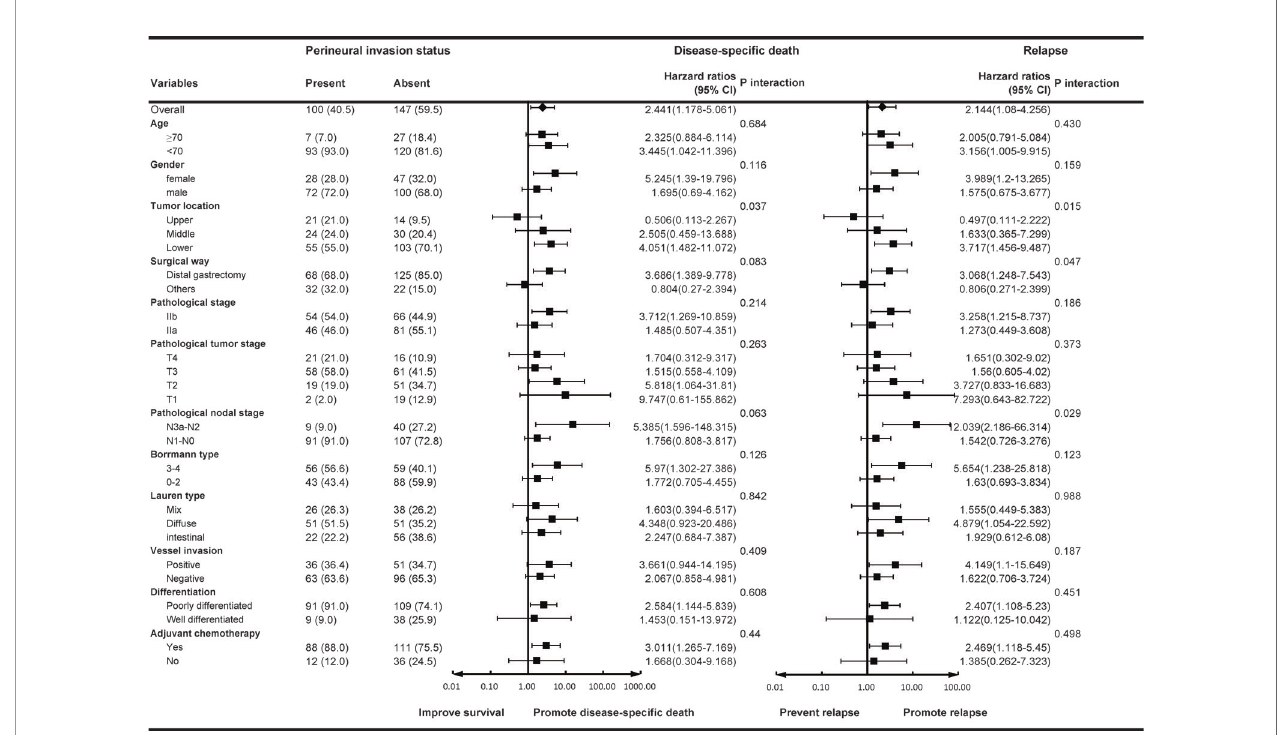
FIGURE 3 | Subgroup forest analyses for nerve invasion. Hazard ratios for disease-speci fi c death/relapse in the patients with nerve invasion are shown with 95%